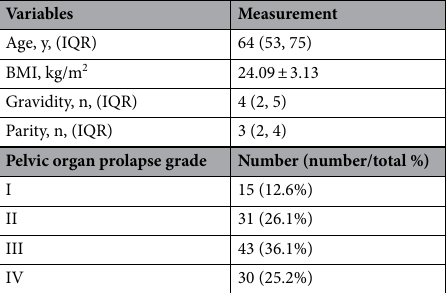
Table 1. General demographics of women with pelvic floor disorders (N = 119). BMI body mass index, IQR interquartile range.